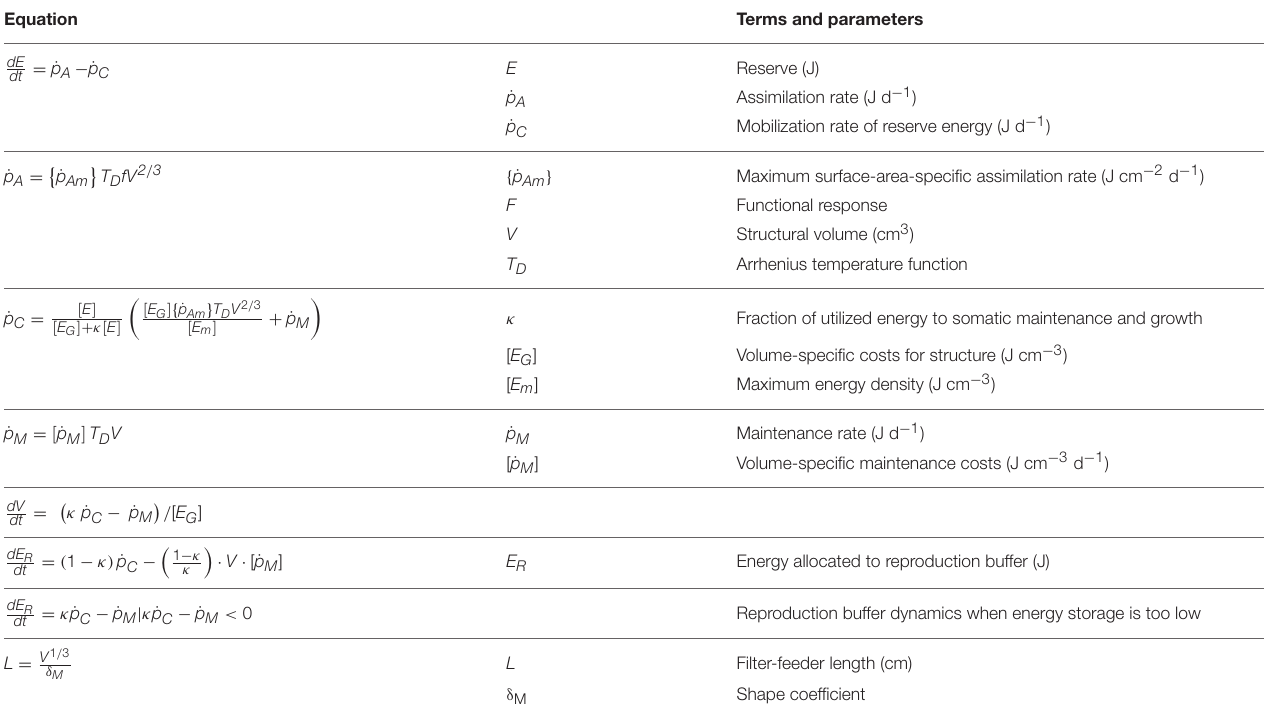
TABLE 1 | Equations used in the Dynamic Energy Budget (DEB) model. Equation